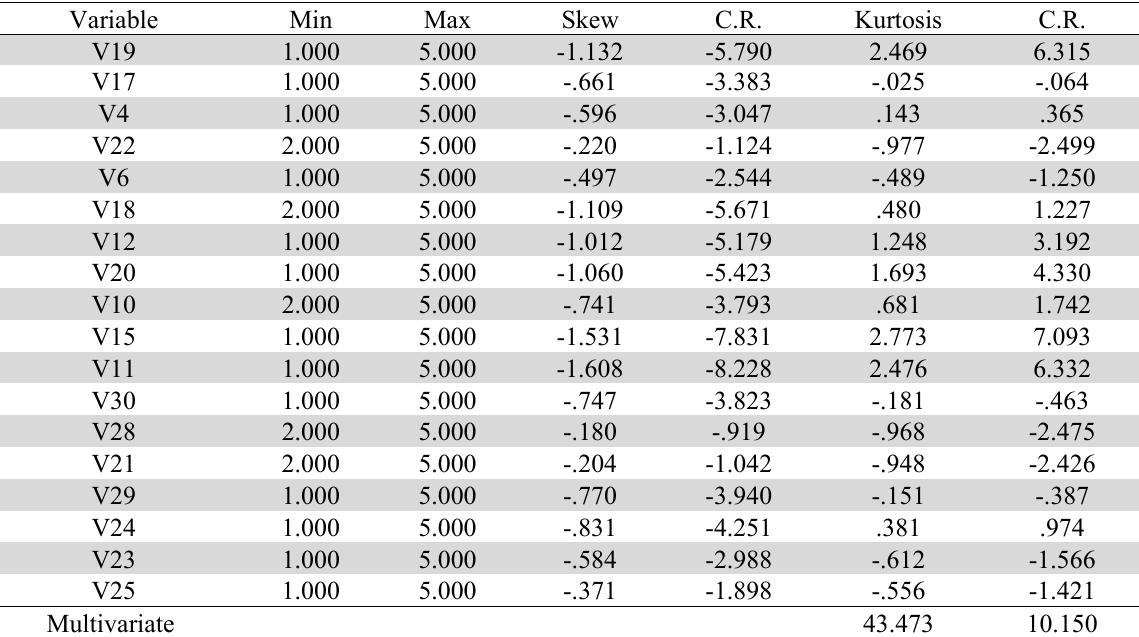
The assessment of normality Variable